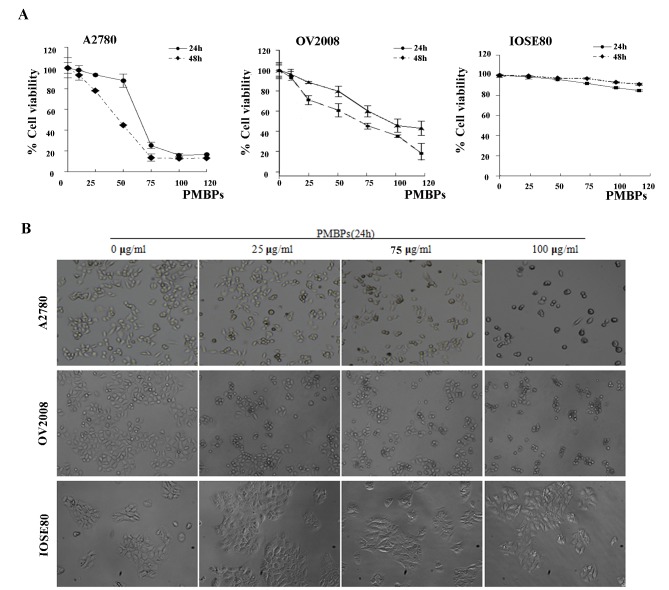
The effects of PMBPs on the viability of ovarian cancer cells and normal ovarian cells.(A) Ovarian cancer cells A2780 and OV2008, and normal ovarian cells IOSE80 were treated with PMBPs (0, 10, 25, 50, 75, 100, 120 μg/ml) for 24 h or 48 h. The cells' viability at the various concentrations of PMBPs were detected by MTT assay and expressed relative to that of non-treated cells. The experiments were repeated three times. (B) Ovarian cancer cells A2780 and OV2008, and normal ovarian cells IOSE80 were treated with PMBPs (0, 25, 75, 100 μg/ml) for 24 h, and cells were photographed with inverted contrast microscopy (magnification, 40×).